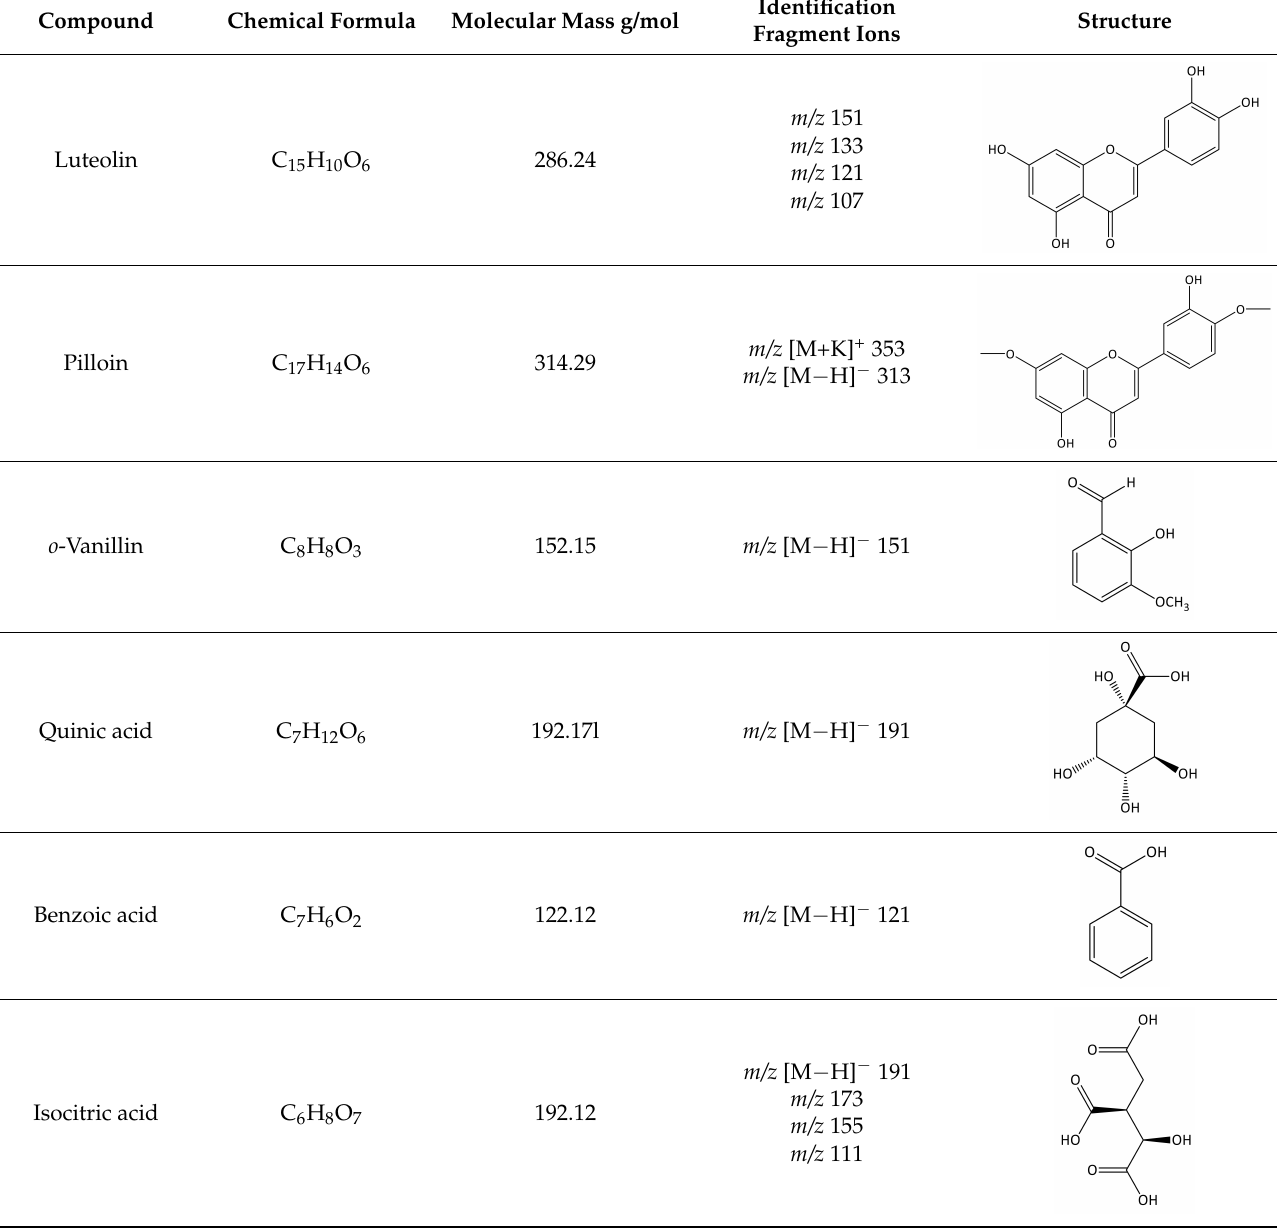
Table 1. The qualitative analysis of BAC compounds in the extracts obtained by means of ESI-MS.